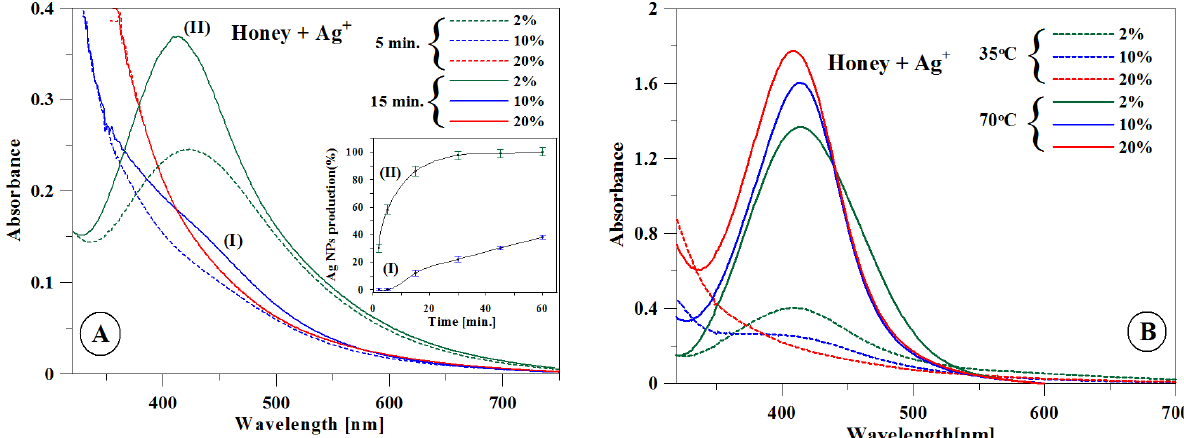
Figure 1. ( A ) Ultraviolet–visible (UV–Vis) spectra of silver nanoparticles (AgNPs) recorded after 5 (dotted line) and 15 min (solid line) for the 2%, 10%, and 20% concentrations at 35 °C. Inset: Changing rate of production of AgNPs measured by changes in absorbance at 400 nm with time. ( B ) Spectra for the 2%, 10%, and 20% concentrations recorded at 35 °C (dotted line) and 70 °C (solid line) after 1 h.